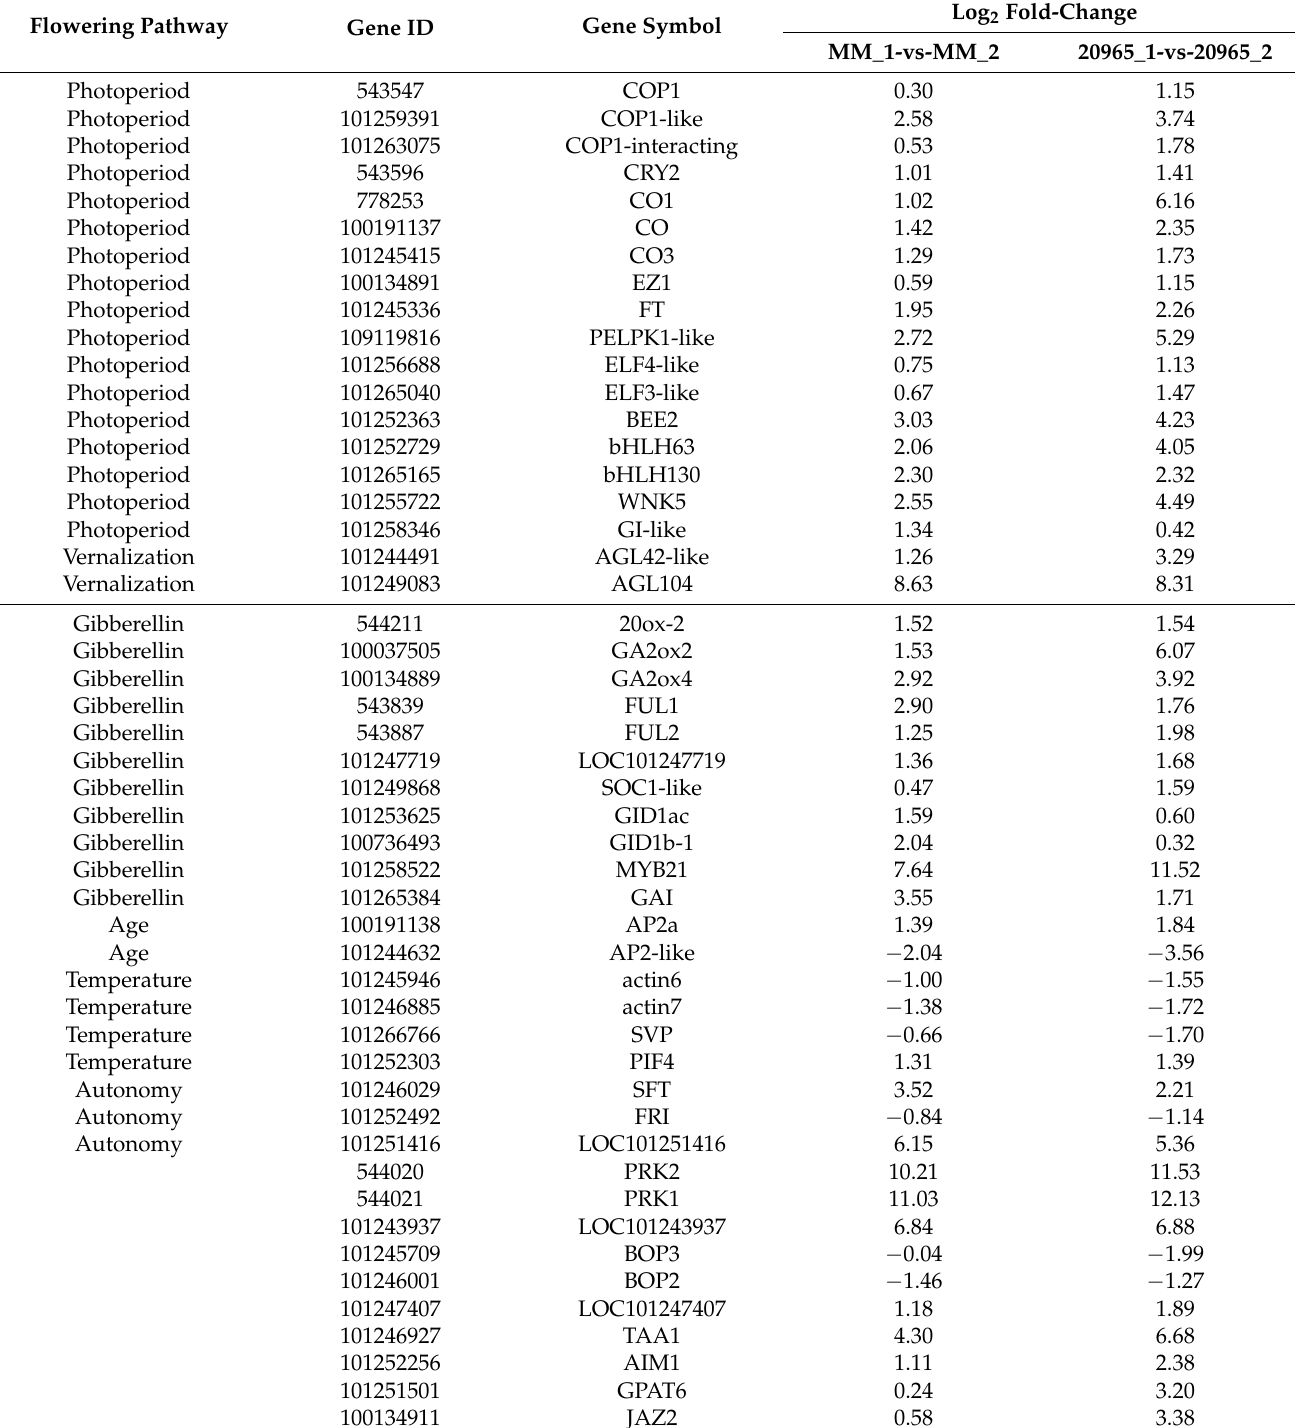
Table 3. Tomato flowering time- and flower development-related genes in the MM_1-vs-MM_2 and 20965_1-vs-20965_2